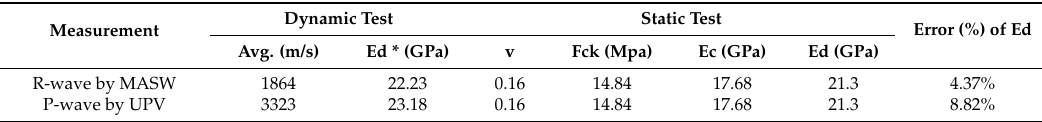
Table 4. Comparison of dynamic moduli from dynamic and static